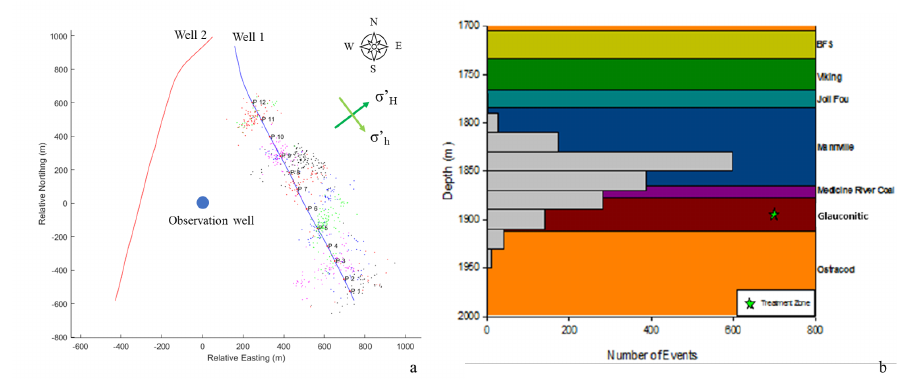
Figure 2. Hoadley field well orientation ( a ) and simplified stratigraphy ( b ). Depth histogram of microseismic events. Gray bars indicate total number of microseismic events recorded at a given depth interval during the hydraulic fracturing [18].